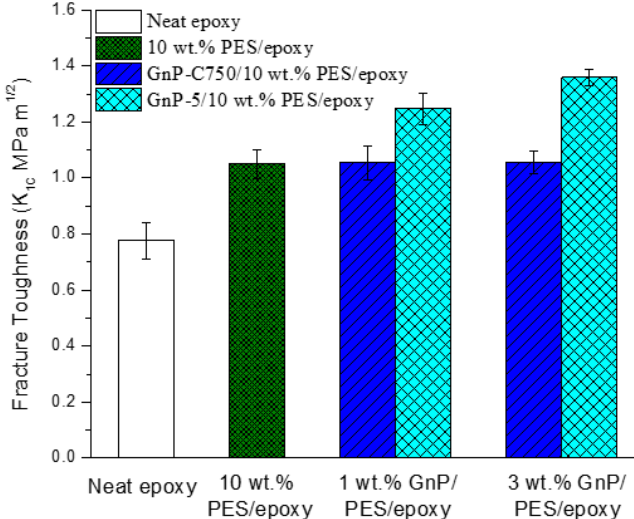
Figure 9. Thermal conductivity of epoxy-based composites.